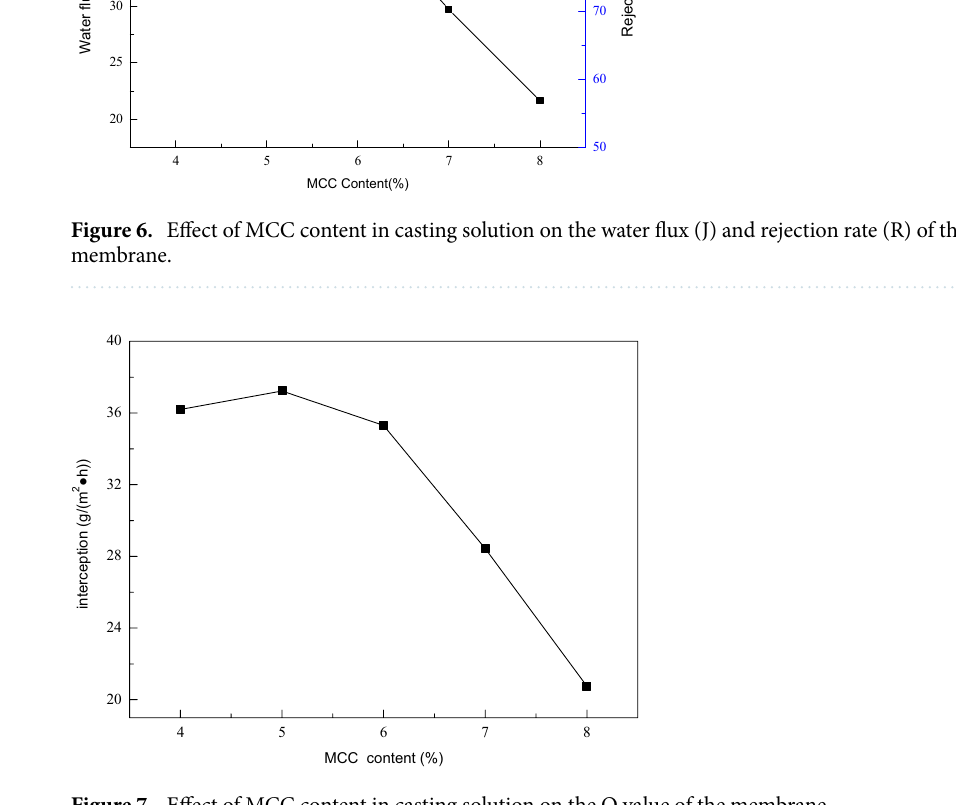
Figure 7. Effect of MCC content in casting solution on the Q value of the membrane.